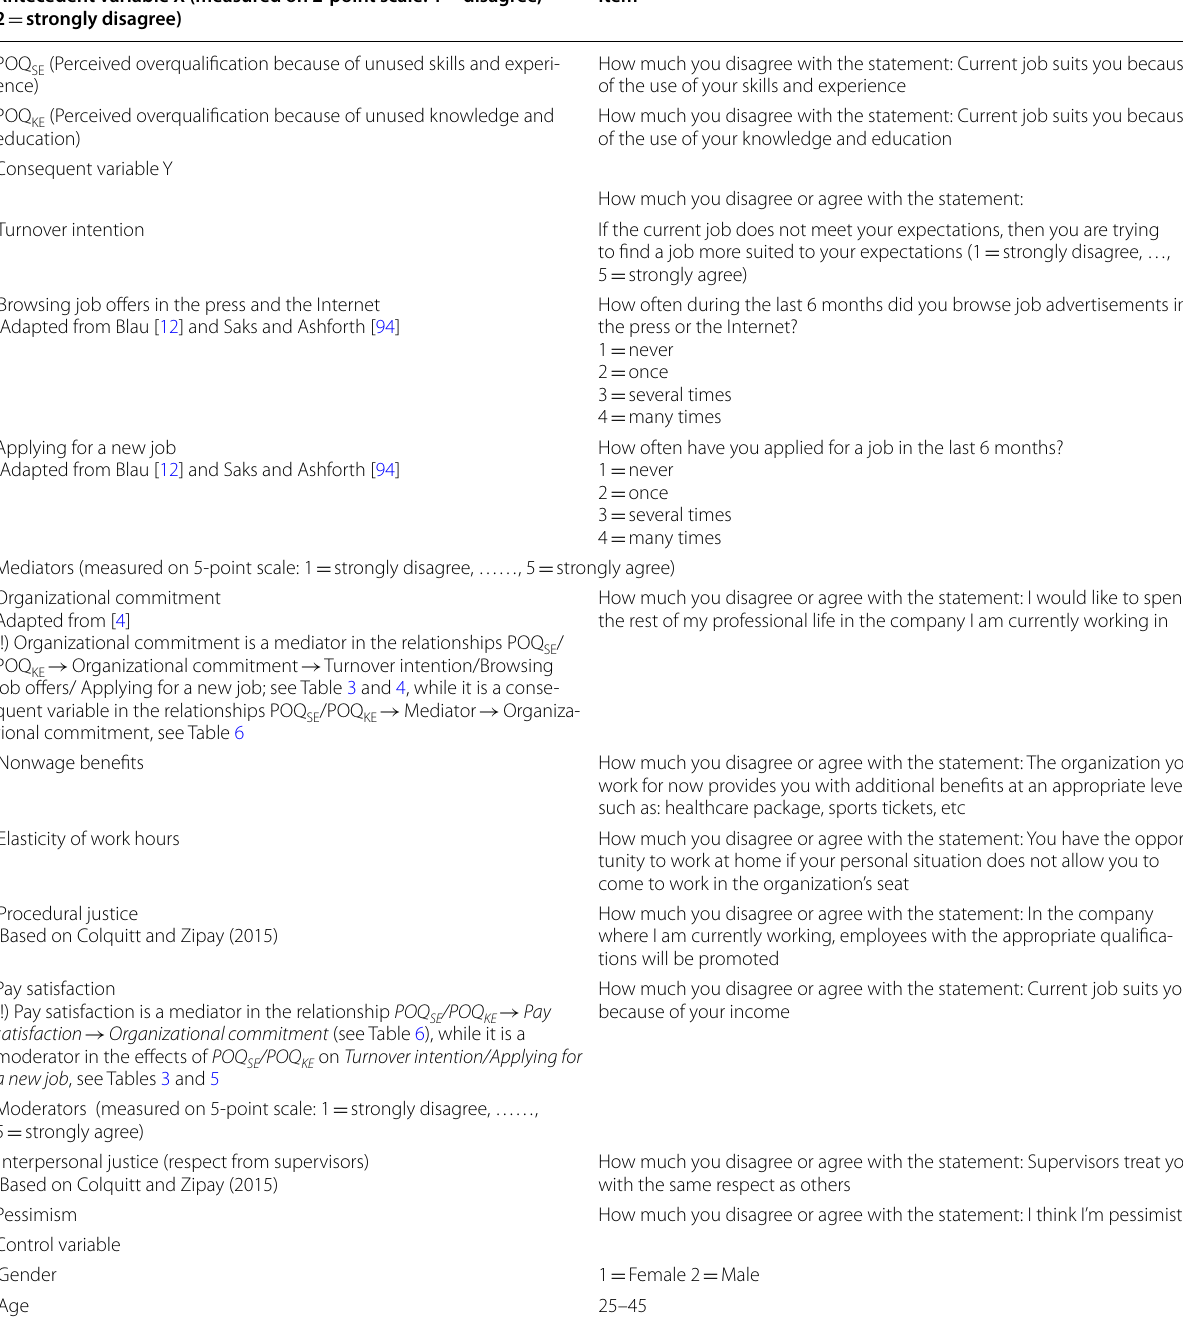
Table 1 Measures of